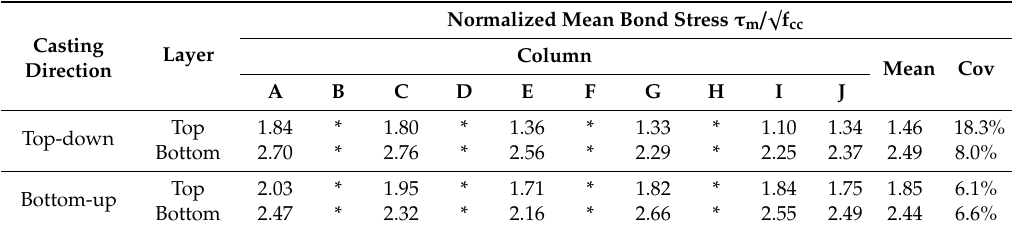
Table 7. Normalized mean bond stress for the rebars in all elements.